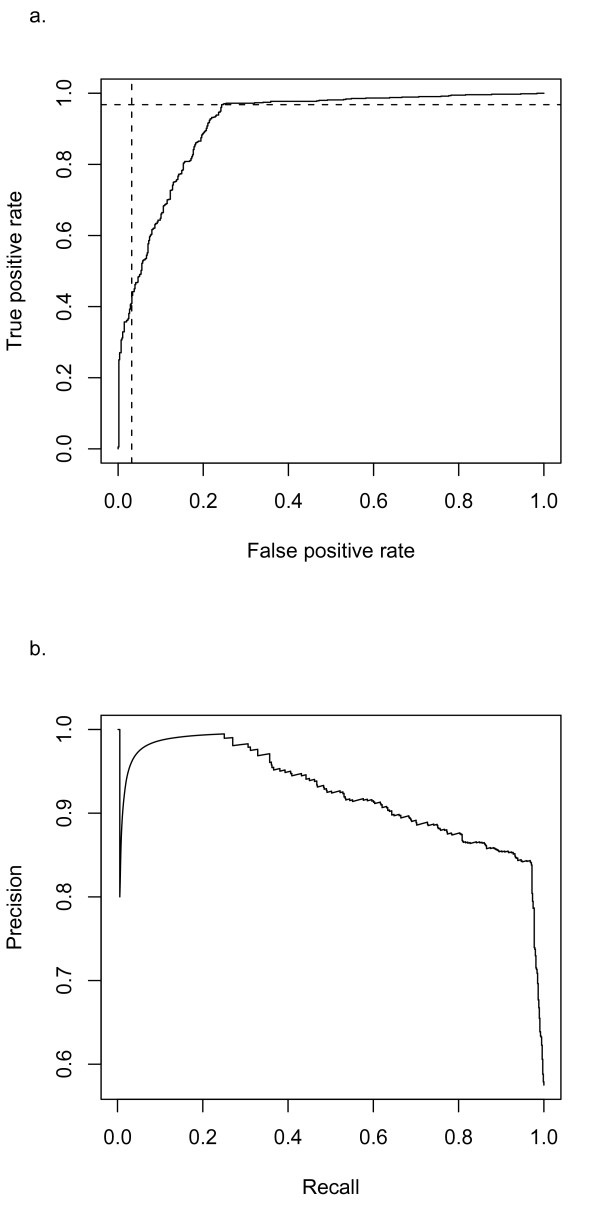
ROC and Precision-recall curve of malaria abstracts. Newly acquired malaria abstracts were classified with the Naïve Bayes classifier trained on all previously expert classified abstracts. The ROC curve was shown in Figure 4a. Horizontal line is the cutoff for "irrelevant" abstracts and vertical line is the cutoff for "relevant" abstracts. Figure 4b is the Precision-Recall curve. The curve shows that at 95% precision, we achieved a recall rate of 36.4%.